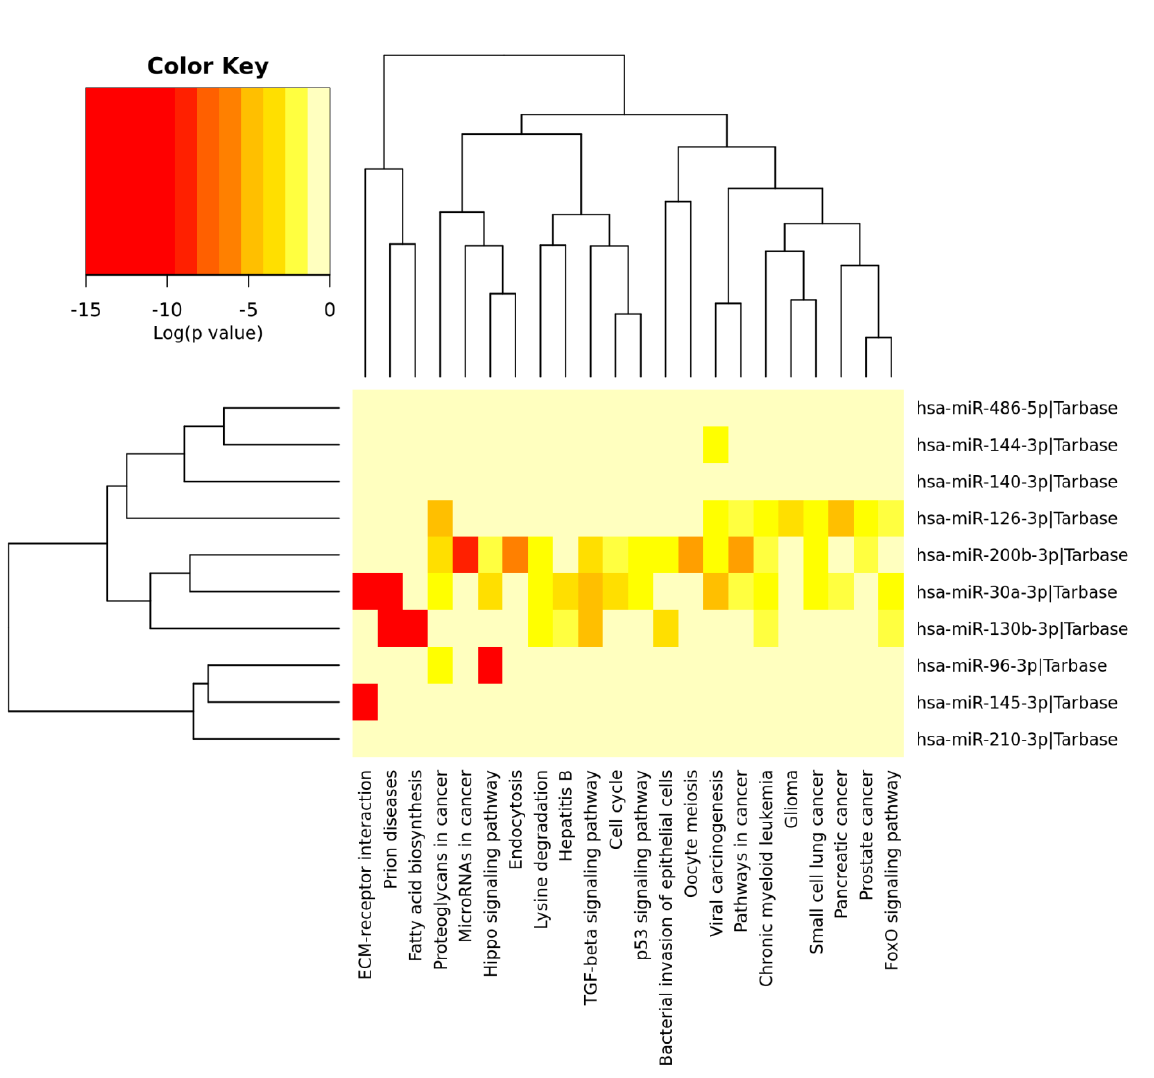
Figure 7. Heatmap of the 10 DEMs (4 upregulated and 6 downregulated miRNAs) showing the top 10 enriched functional pathways ( X ₋ axis represents the name of the pathways and Y ₋ axis represents the